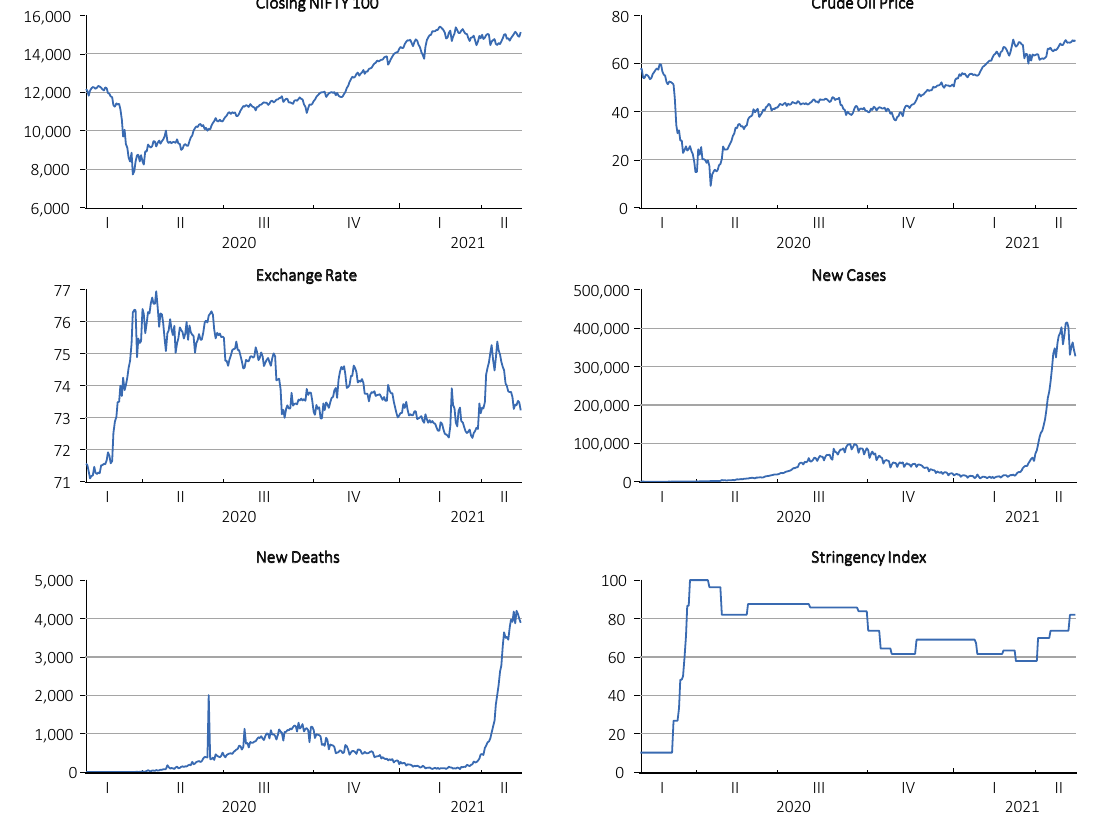
Figure 1. Trend of selected